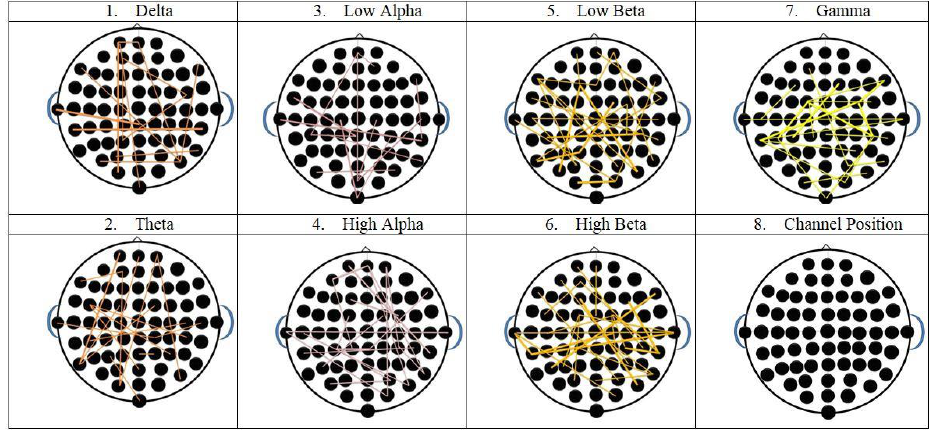
Figure 9. Identification of the complex emotions with the most significant qualities, amplitude time series correlation analysis was carried out.